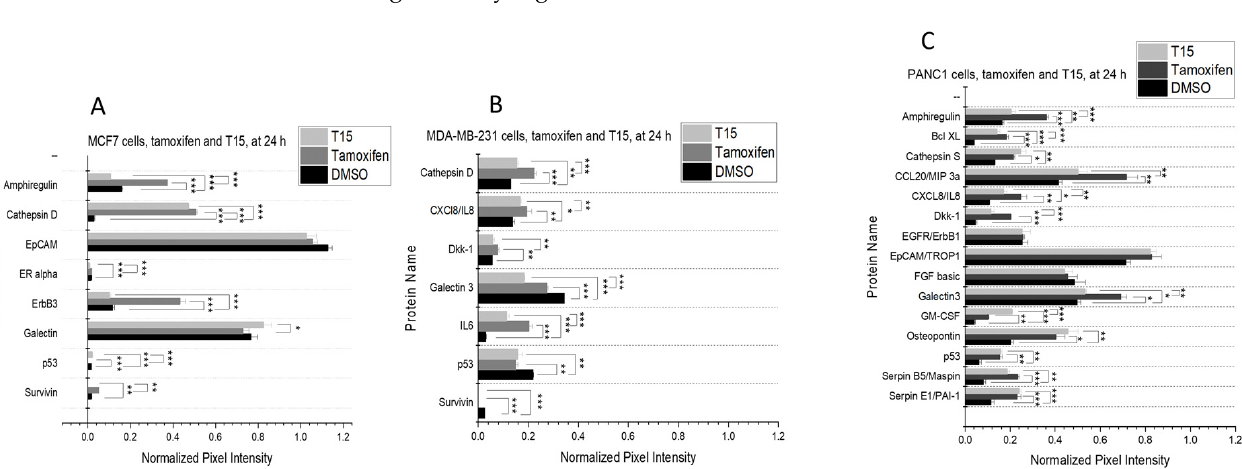
Figure 5. Impact of tamoxifen ( A ): MCF7, ( B ): MDA-MB-231, ( C ): PANC1), T5 ( D ): MCF7, ( E ): MDA- MB-231, ( F ): PANC1) and T15 (( G ): MCF7, ( H ): MDA-MB-231, ( I ): PANC1) on the ROS production of the model cells. Each cell line was treated with 0.5, 2.5, and 25 µM tamoxifen derivatives, and 600 nM bortezomib (Bort.) was chosen as a positive control due to its well-known oxidative stress-in- creasing property. Each column on the graph represents the measurement of three parallel samples ( n = 3). Data are given as mean values ± standard deviation (SD). Asterisks mark the concentrations, where the ROS production was significantly higher compared to the untreated, negative, medium control ( p < 0.05: *, p < 0.01: **, p < 0.001: ***) determined by the One-way ANOVA test followed by Fisher’s LSD post hoc test.